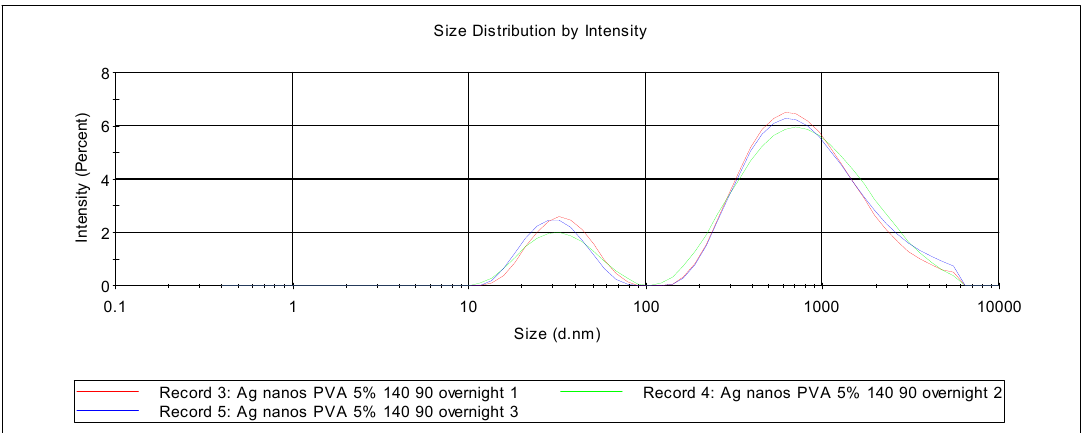
Figure 4. Particle size analysis of the aqueous release medium after immersing PVA/silver film (5% w/w silver nitrate, heat cured at 140 °C for 90 min) in deionized water overnight.